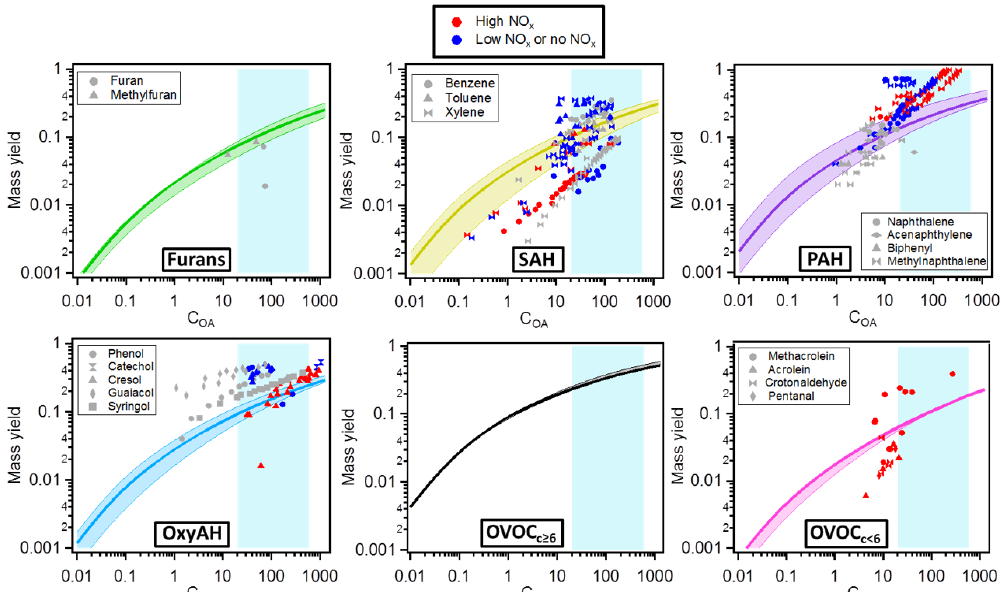
Figure 9. Mass yields for each class of compounds. The solid lines represent the median values while the lower and upper limits are the 25th and 75th percentiles, respectively. The different markers in each plot are yields published in the literature for different single compounds (see Table S2). The colour code denotes different NO x regimes (red denoting high NO x , blue low or no NO x and grey not specified NO x regimes). The shaded background represents the range of our experiments (20–600µgm − 3 ); outside this shaded area yields are extrapolated from the model.